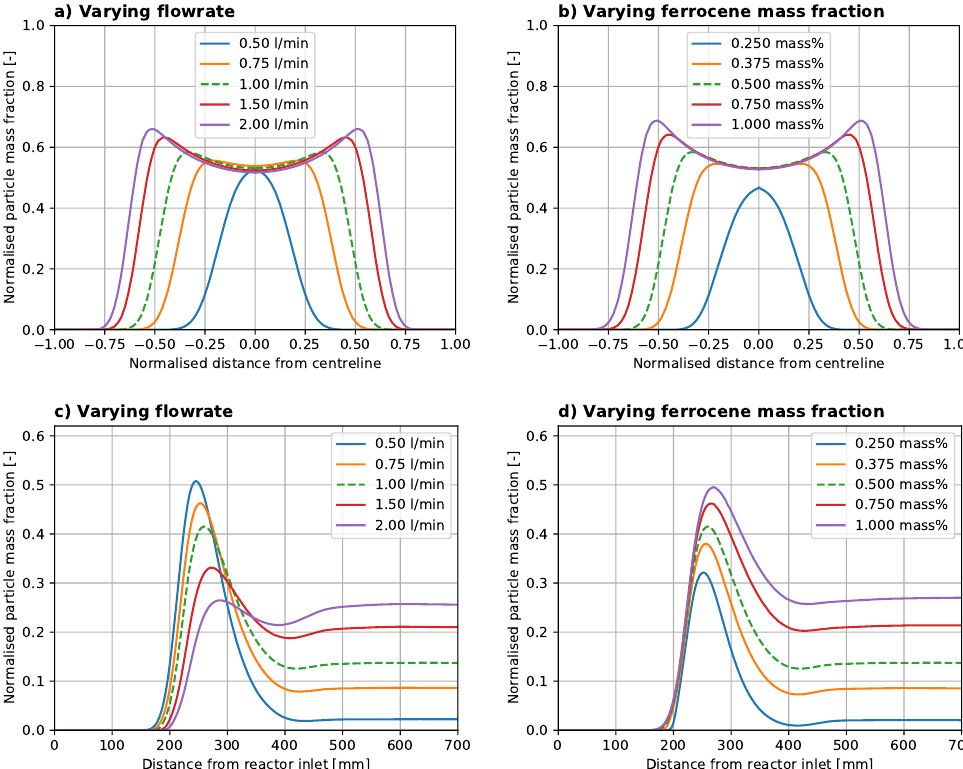
Figure 5. Plots of the normalised particle mass fraction: ( a , b ) the radial profile of the particle mass fraction, 500mm downstream from the inlet; ( c , d ) the axial profile of the particle mass fraction, averaged over the reactor radius; ( a , c ) the variations with flow rate (at 1250 ◦ C peak temperature and 0.5mass% ferrocene mass fraction); and ( b , d ) the variations with input iron mass (at 1lmin − 1 and 1250 ◦ C peak